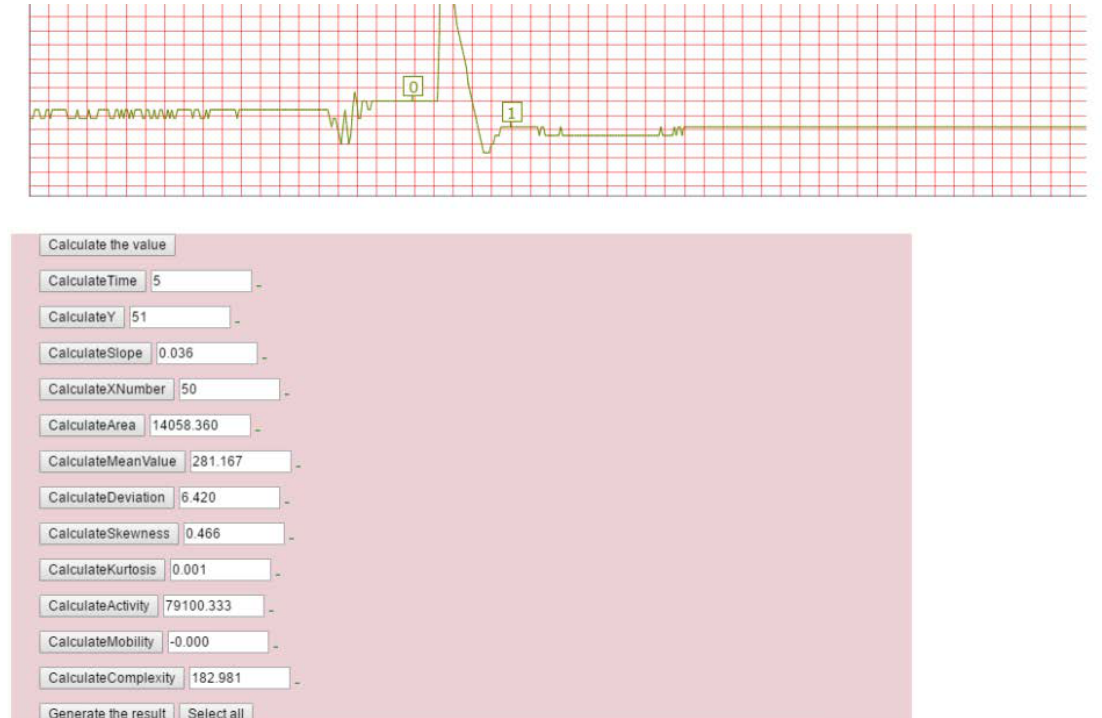
Figure 12. Calculation features of plant electrical signals.